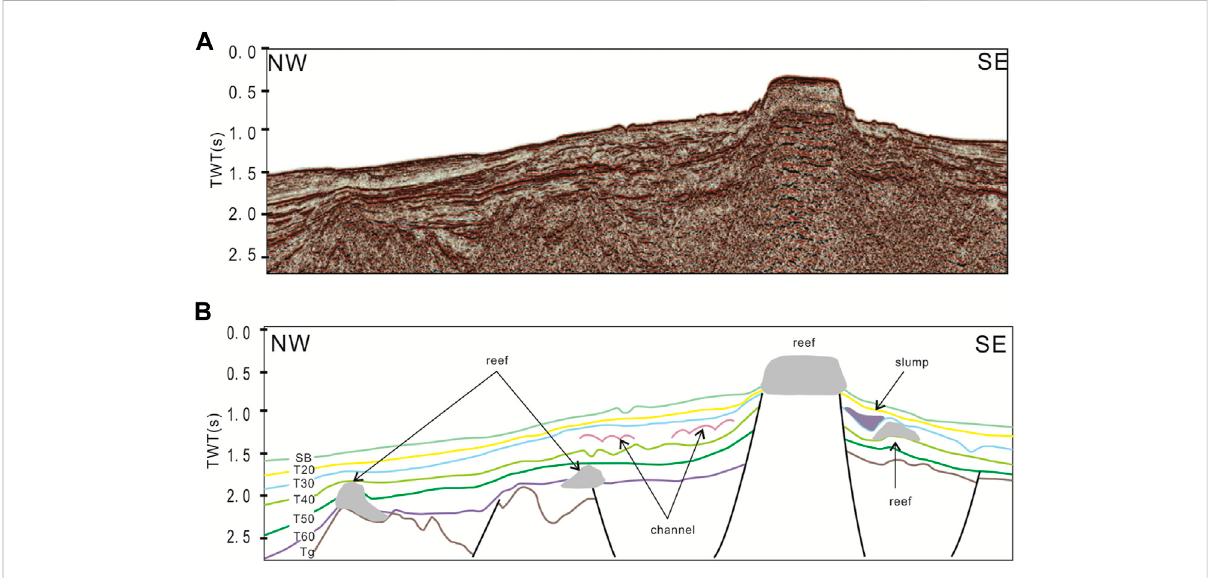
FIGURE 3 Seismic sequence stratigraphy across the Xisha Uplift in the South China Sea. (A) Uninterpreted and (B) interpreted sections. SB is the sea fl oor re fl ector, and T20, T30, T40, T50, and T60 represent the bottom of the Quaternary, Pliocene, Late Miocene, Middle Miocene, and Early Miocene, respectively. Seismic re fl ector Tg is the acoustic basement re fl